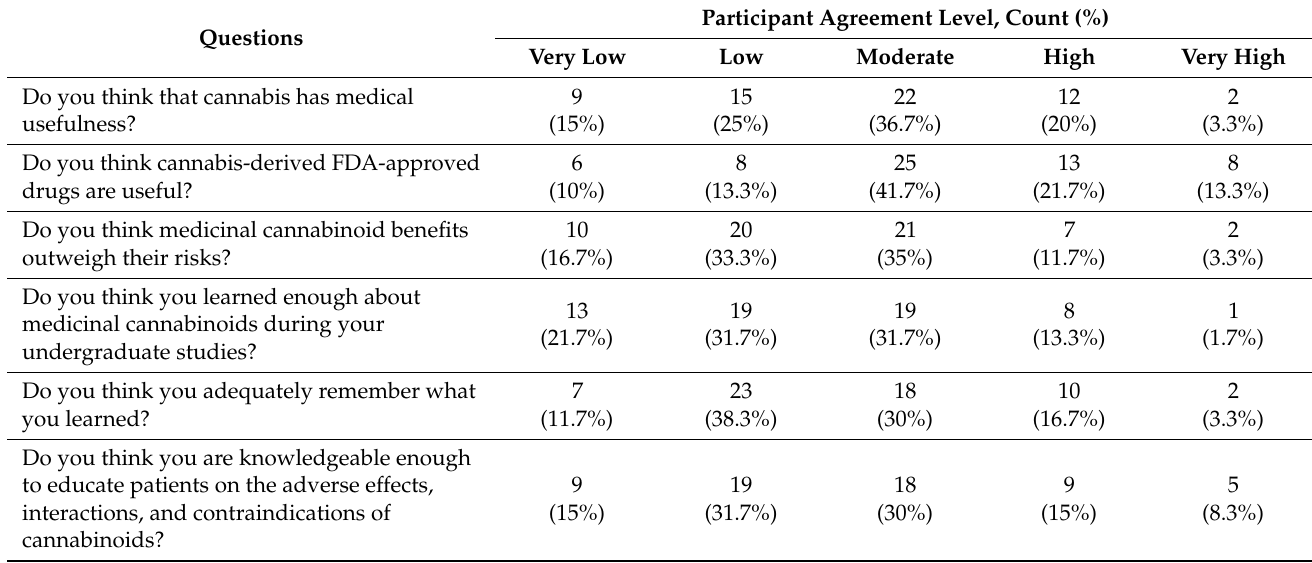
Table 2. Participant attitudes towards medicinal cannabinoid usefulness and education.